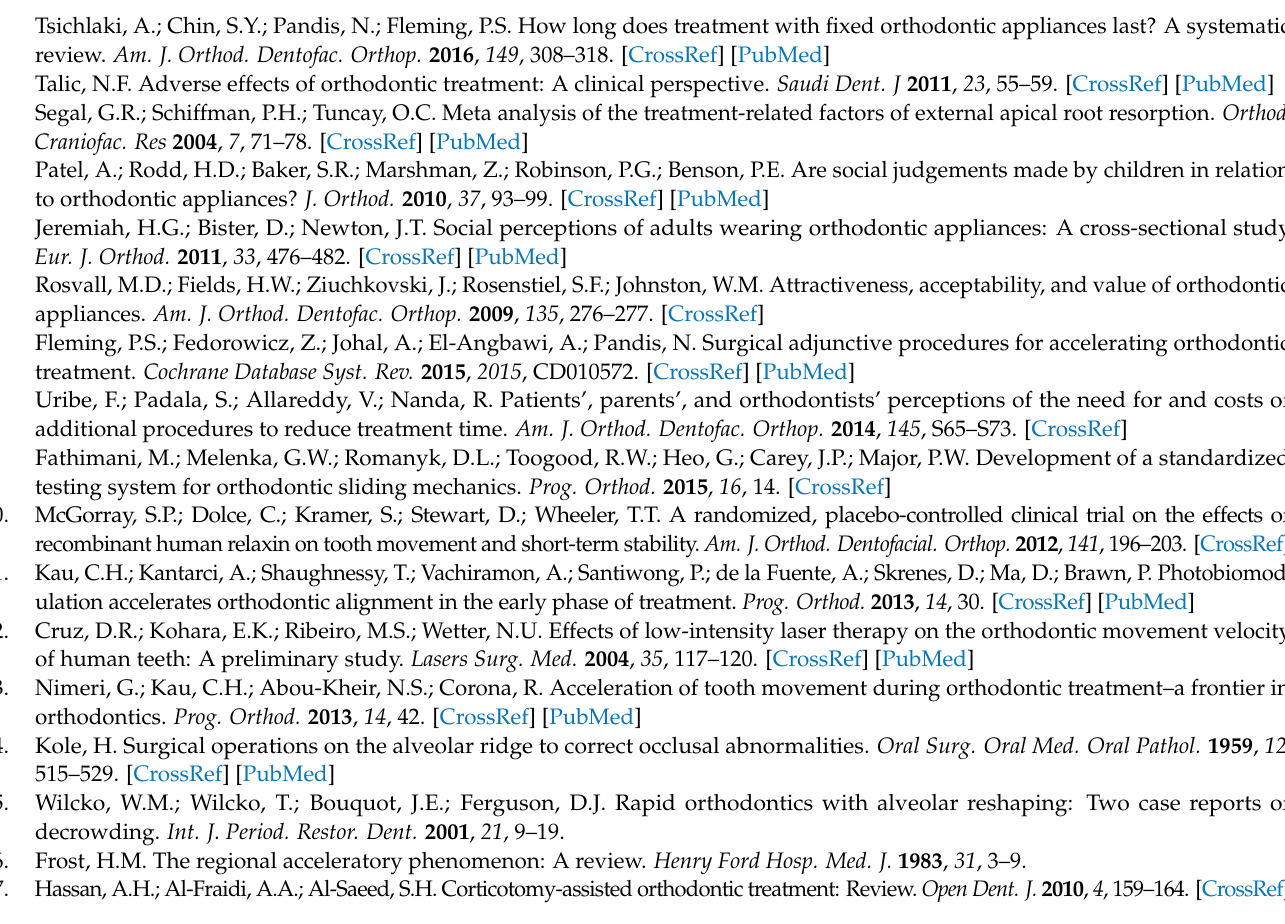
Table A4. Risk of bias of included non-randomized studies according to ROBINS-I tool. Selection Study of Partici- Confounding pants into the Study